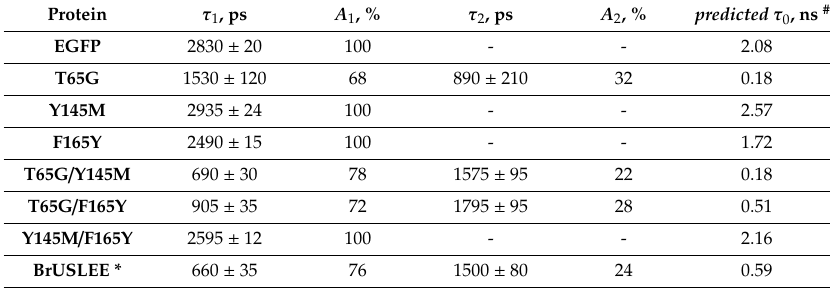
Table 2. Fluorescence lifetimes of EGFP, 65th-, 145th-, and 165th-position mutants and their combinations. Protein τ 1 , ps A 1 , % τ 2 , ps